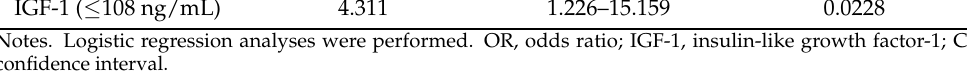
Table 4. Odds ratios of IGF-1 ( ≤ 108 ng/mL) for a “decline in masticatory function”. OR 95% CI p IGF-1 ( ≤ 108 ng/mL)